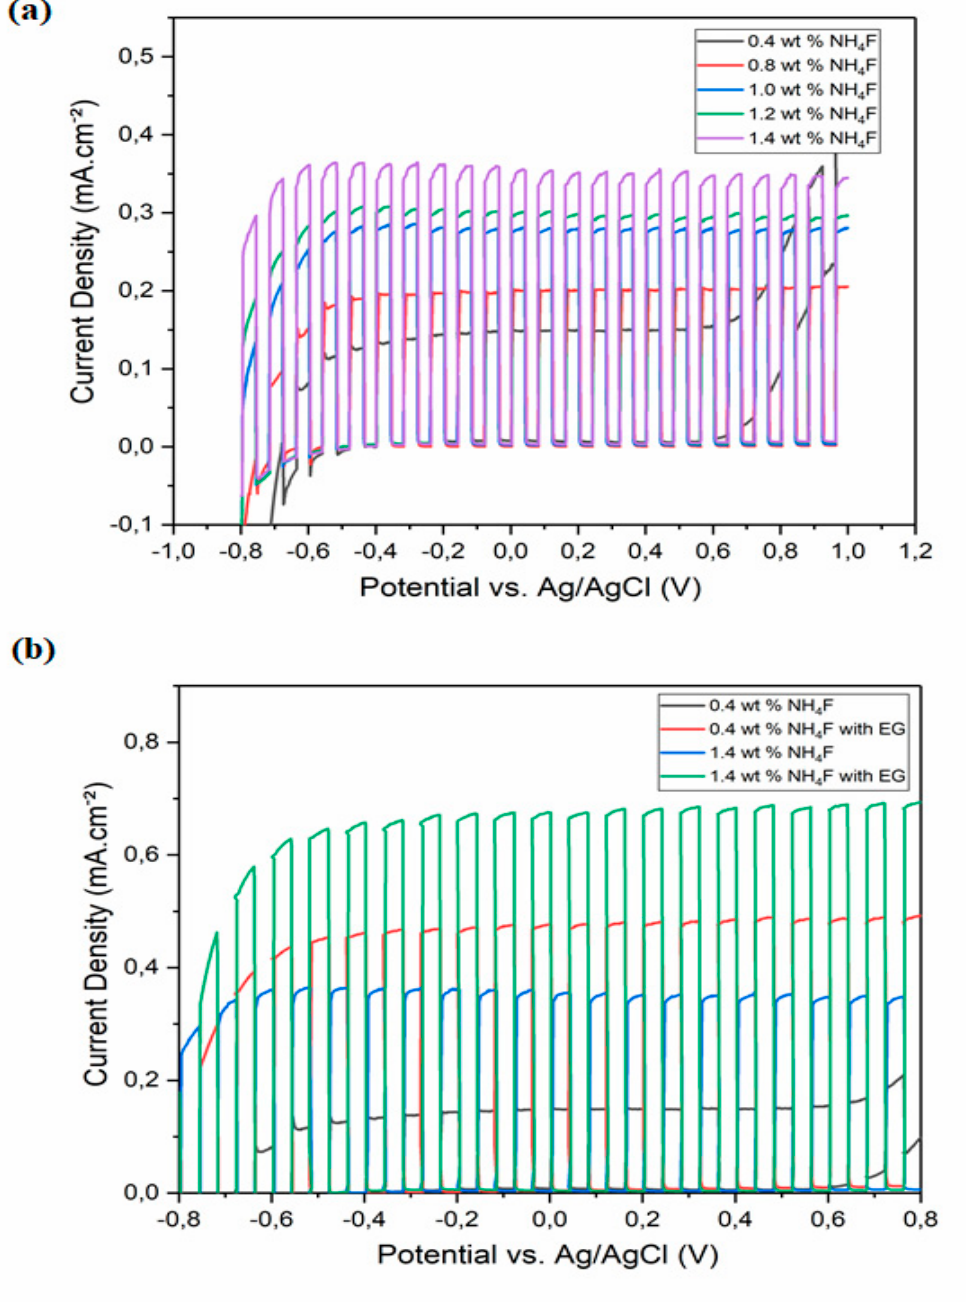
Figure 4. Current transient of the TiO 2 nanotubes prepared using different ammonium fluoride concentrations ( a ) without ethylene glycol ( b ) with ethylene glycol added (samples prepared using constant anodization time (30 min) and anodization voltage (30 V), annealed at 420 °C for 90 min).